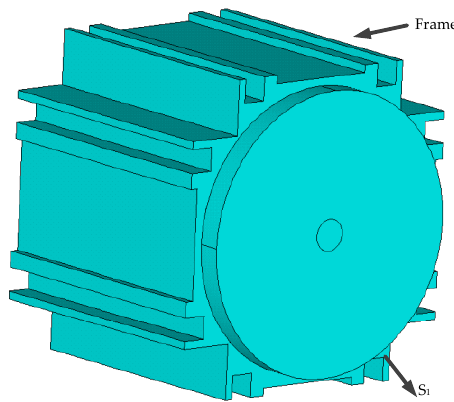
Figure 3. 3-D temperature field analysis model of the PMSM.